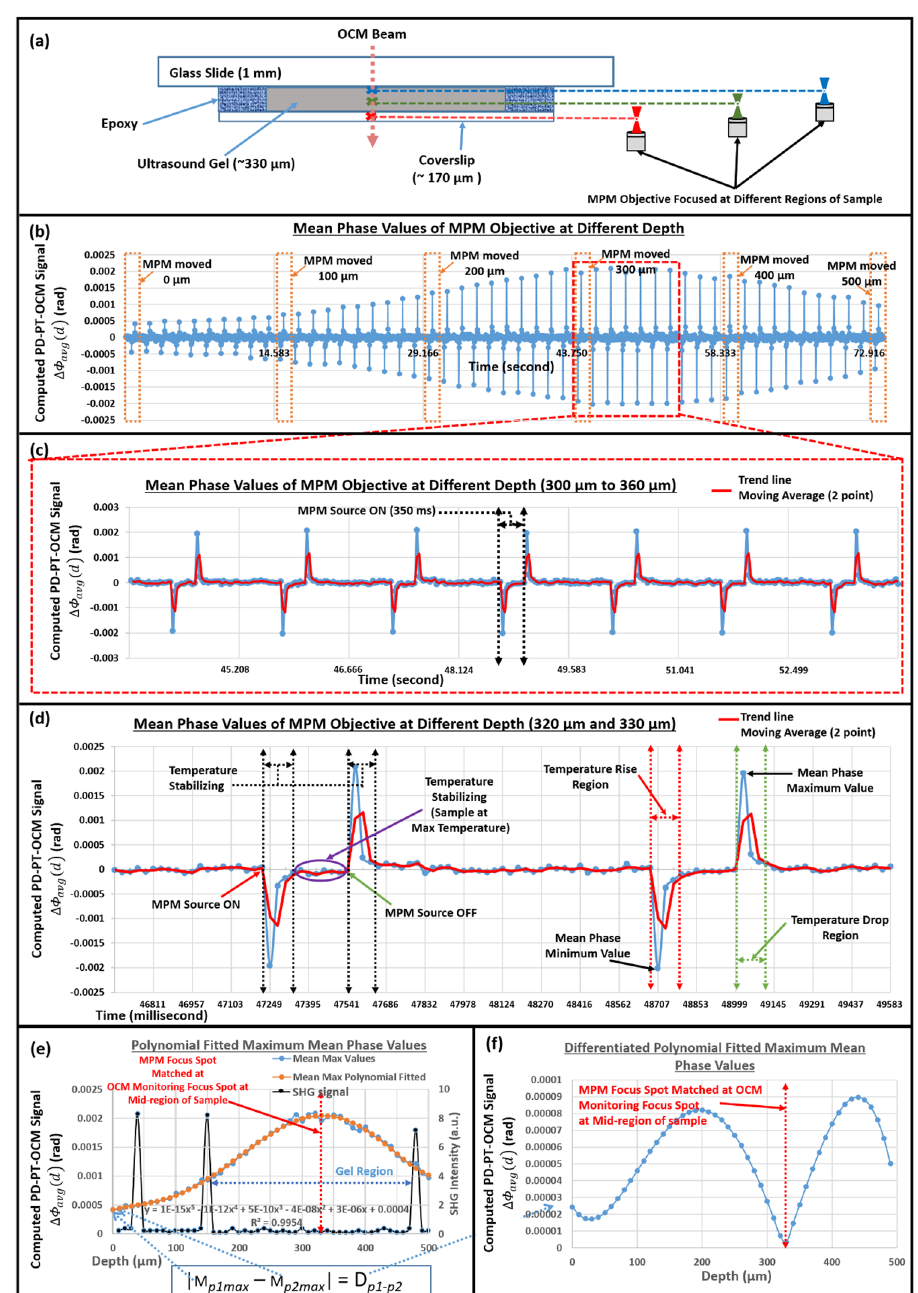
Figure 3. PD–PT OCM signal analysis using a simple phantom sample. ( a ) is the figurative description of MPM focus position movement over varied depth. ( b ) is the complete photothermal response observed in the simple phantom sample within a depth range of 500 µm. ( c ) is the enlarged graph of the photothermal response observed in the middle region of the sample. ( d ) is the peak photothermal response observable within the sample. ( e ) is the maximum mean phase values plotted against the depth range of 500 µm in the sample. ( f ) is the graph plotted from the absolute difference between successive values in ( b ). Figure ( a ) is not drawn to